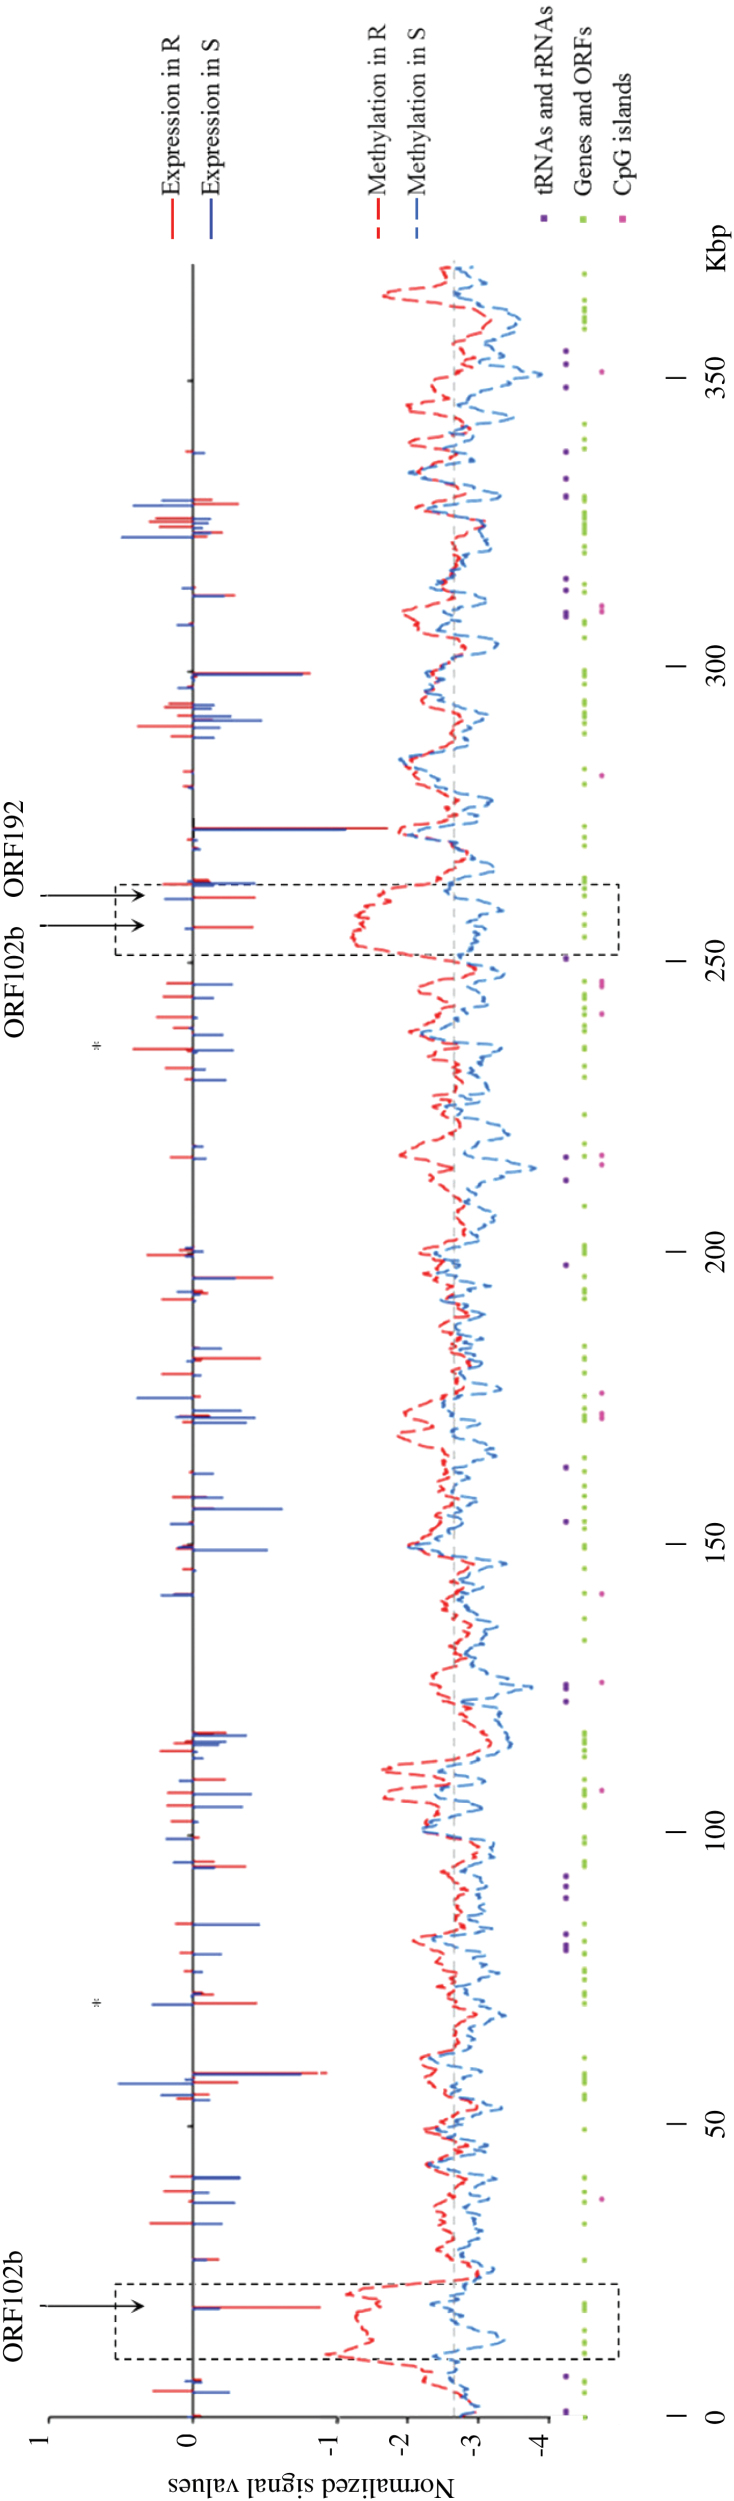
Expression and DNA methylation level analysis in the mitochondrial genome of sugar beet genotypes after vernalization. The three bolting-resistant (R, red lines) and the three bolting-sensitive (S, blue lines) genotypes have the same mitochondrial haplotype (‘O’ type, i.e. normal type mitochondrial genome leading to fertility, in contrast to the cytoplasmic male-sterile type) and were vernalized during 9 weeks at 4 °C. Green squares represent ORFs, purple squares represent rRNAs and tRNAs, and pink squares represent CpG islands. Black frames correspond to differentially methylated region-rich loci. Significantly different values for transcriptomic probes are marked with an asterisk (*P<0.05).